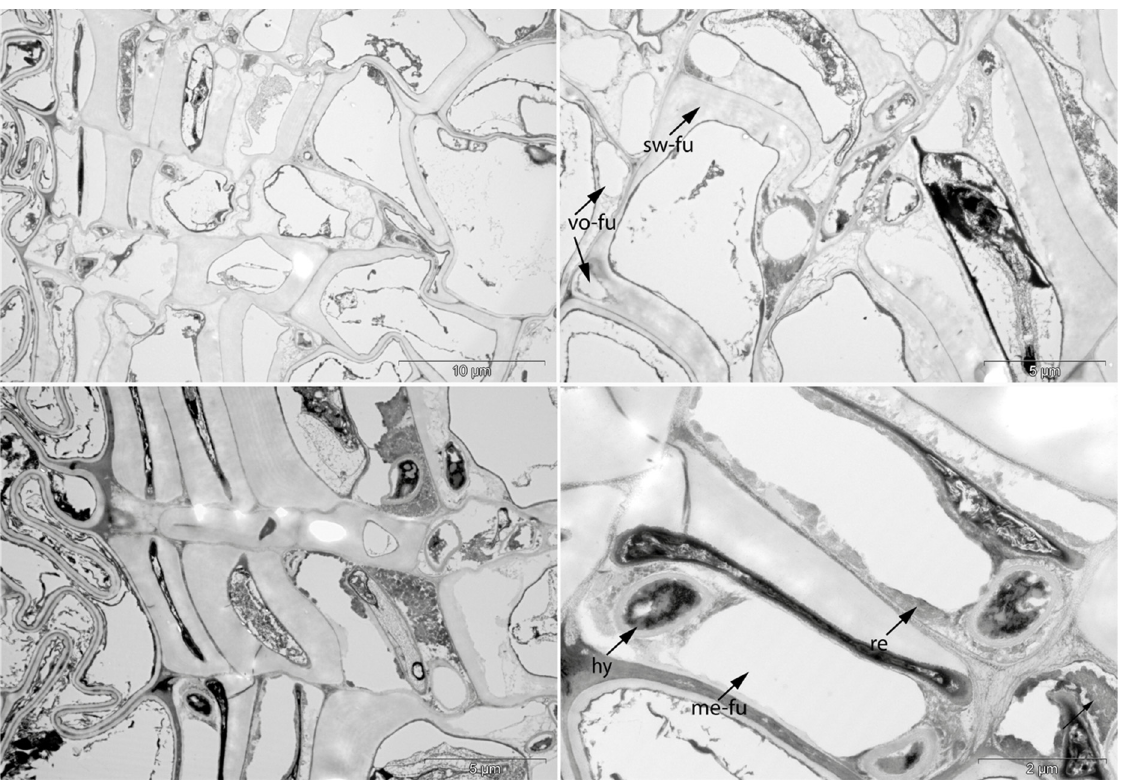
Figure 15. Sample 0. TEM images illustrating degradation feature called circular voids. At top right, empty cavities not filled with hyphae are visible (vo-fu). In the same picture, swelling and loosening of secondary cell wall can be seen (sw-fu). At bottom right, cells with corners penetrated by hyphae (hy) are visible. These have almost completely metabolised the suberised wall, leaving only a little granular dark residue (re).